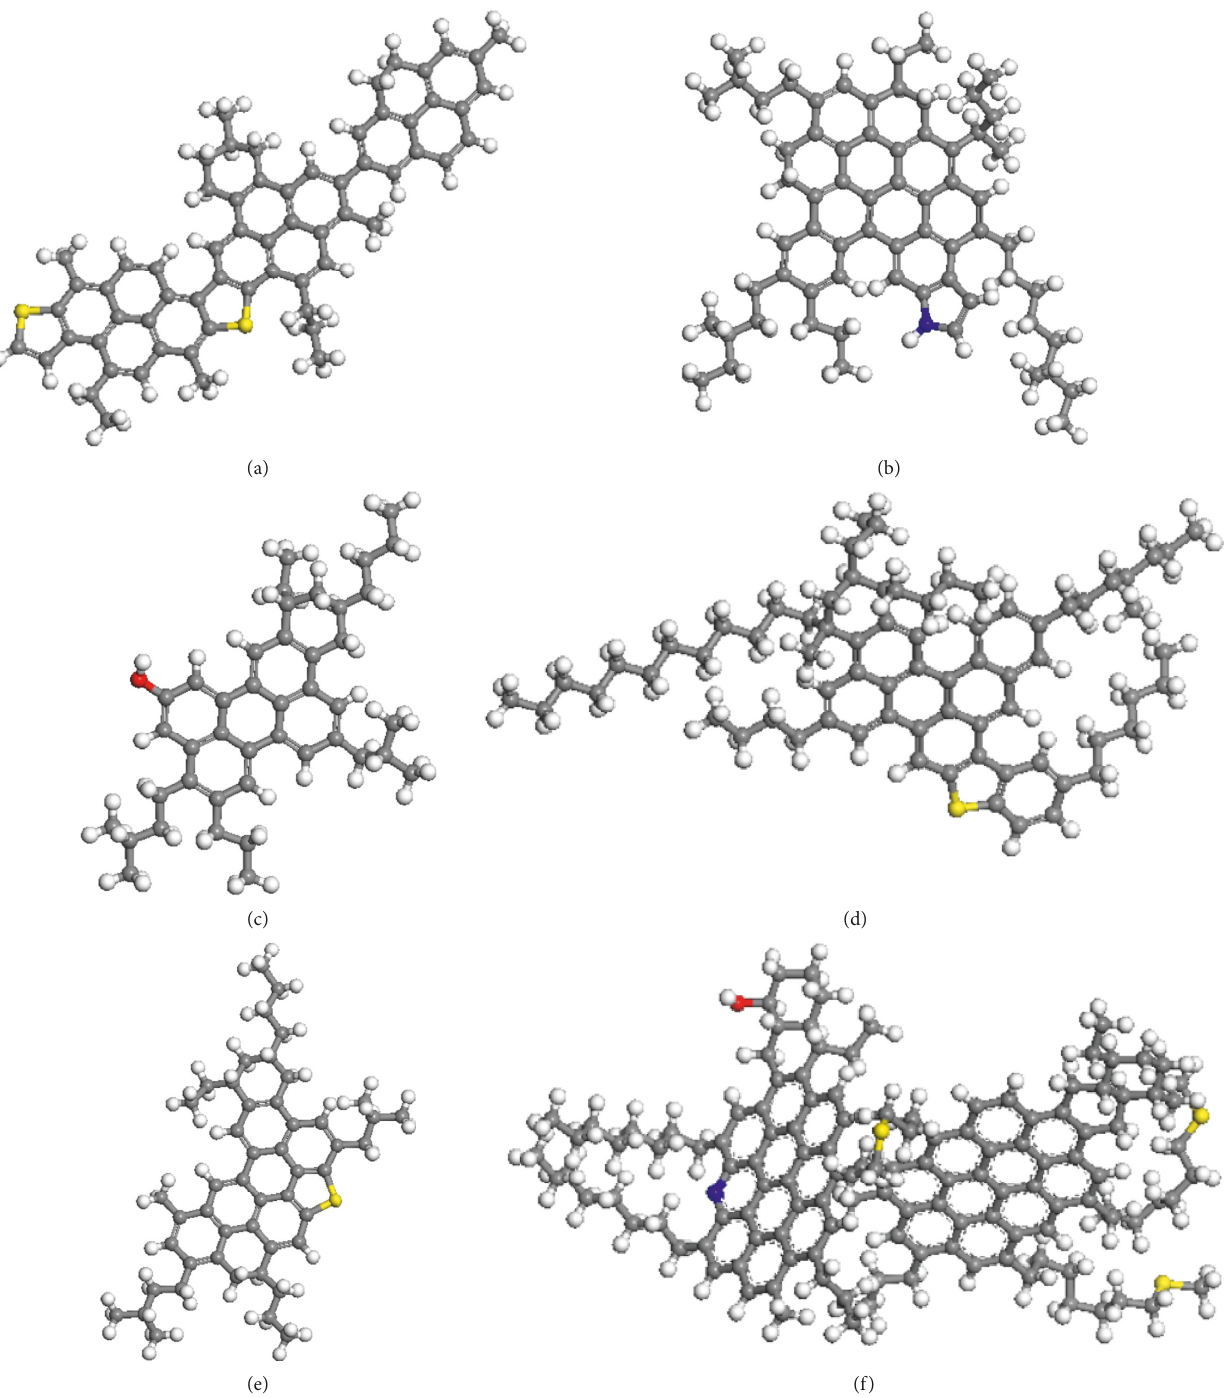
Figure 7: Typical molecular structures for asphaltenes [94, 95, 98,